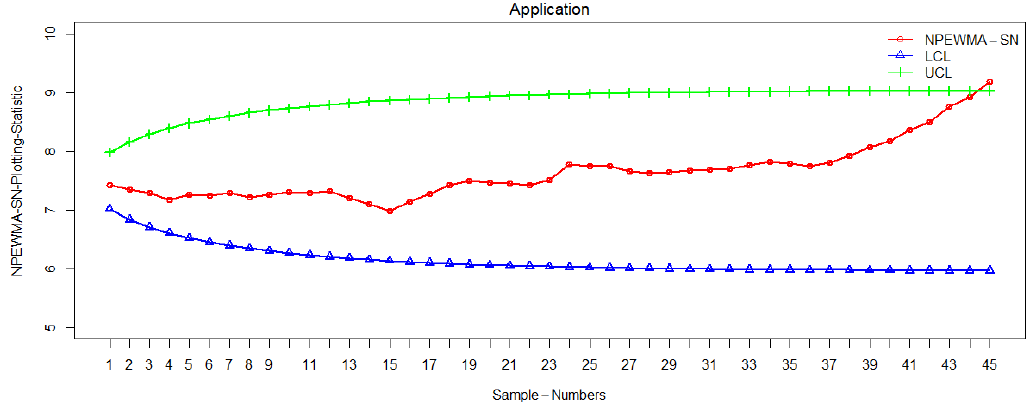
Figure 8. Real-life application of the NPEWMA-SN control chart in a hard-bake manufacturing process.